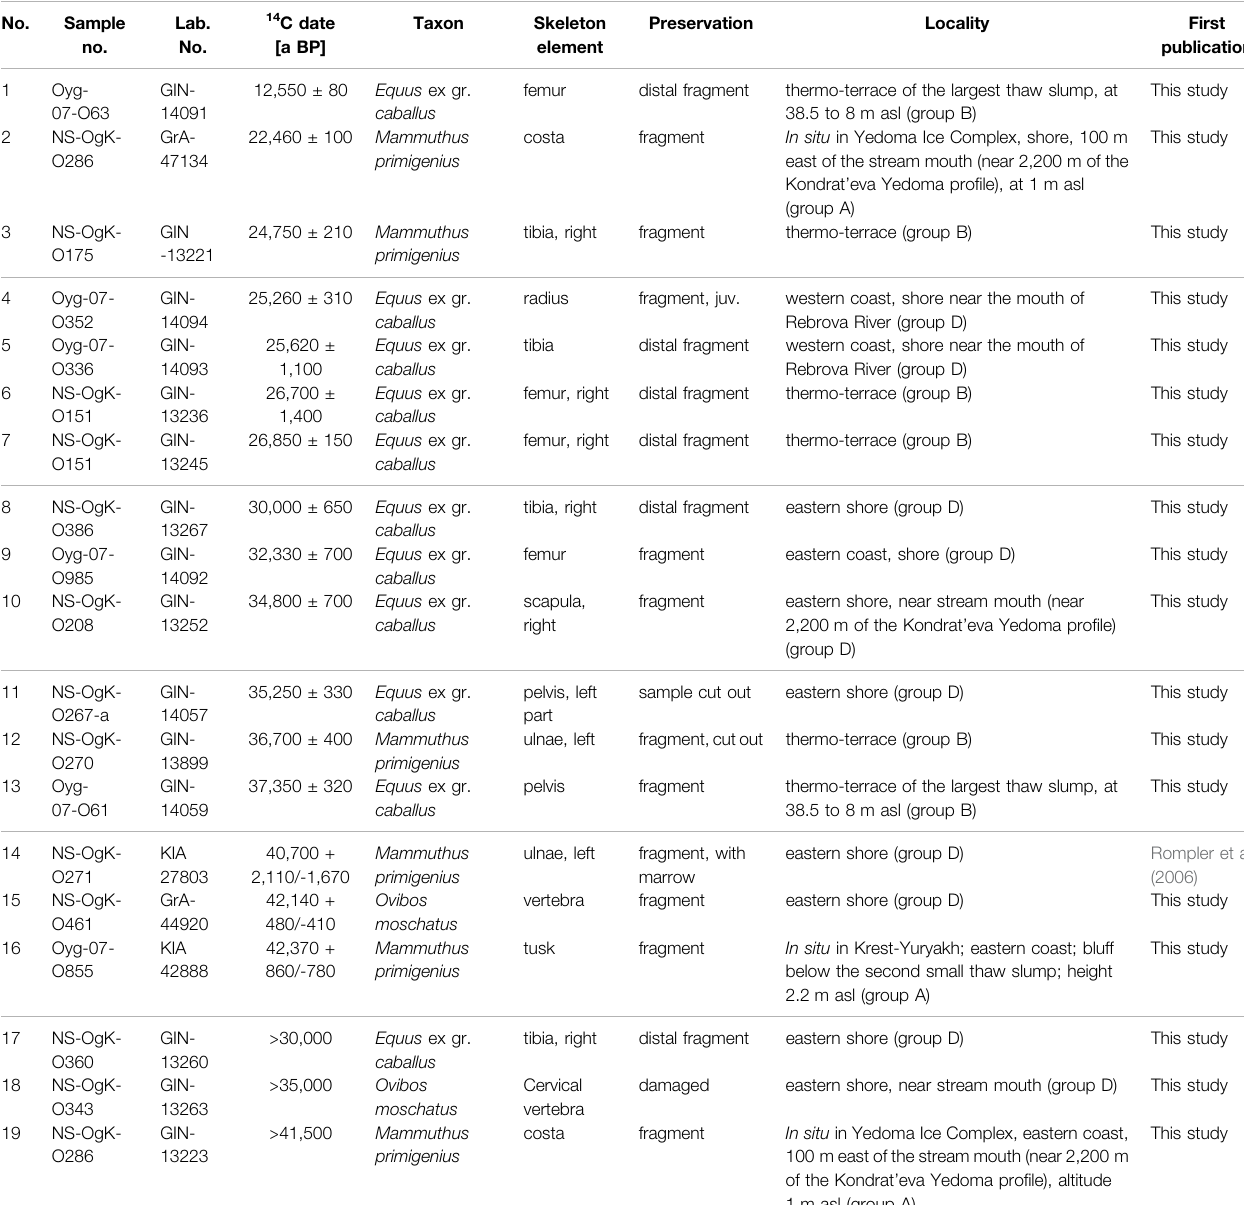
TABLE 2 | List of radiocarbon dates derived from collagen of Mammoth fauna bones collected at Oyogos Yar shown in order of increasing age. GIN - Geological Institute of theRussian Academy ofSciences, Moscow(Russia);GrA — Center ofIsotope Research UniversityofGroningen(Netherlands); KIA — Leibniz Laboratory forRadiometric Dating and Stable Isotope Research University of Kiel (Germany). Samples 2 and 19 were taken from the same costa of Mammuthus primigenius . No. Sample